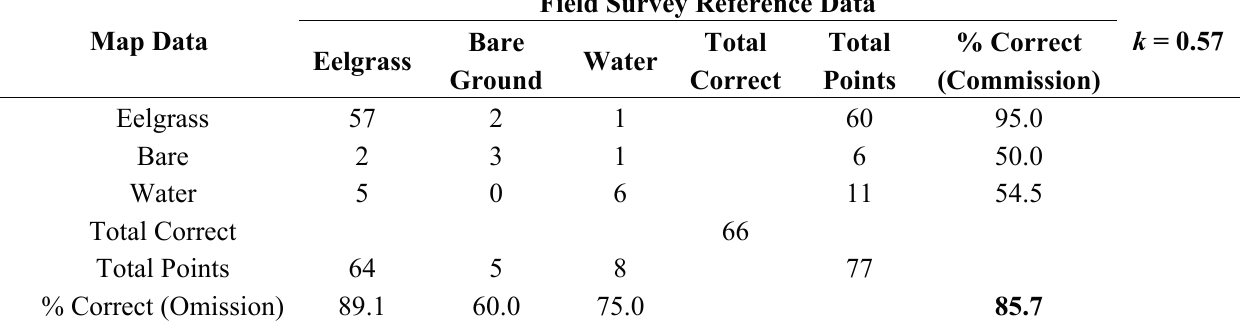
Table A3. Initial classification of habitats in Hook Bay.